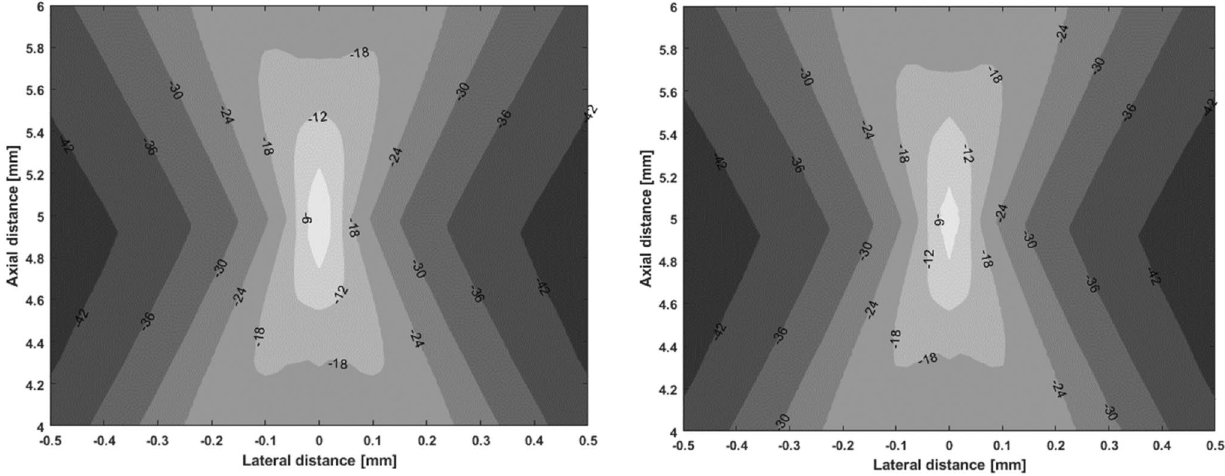
Fig. 9 Simulated pressure field contours (in dB) of the not optimized probe (left) and the optimized probe (right). This simulation is done using the Field II